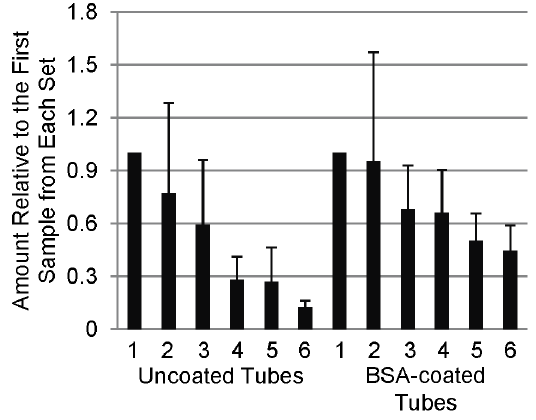
Figure 2. Depletion of SP-D in Solution During Serial Transfers. 5 m l aliquots were taken from a serially transferred solution of SP-D after each incubation, analyzed by Western blot, and quantified using ImageJ software.